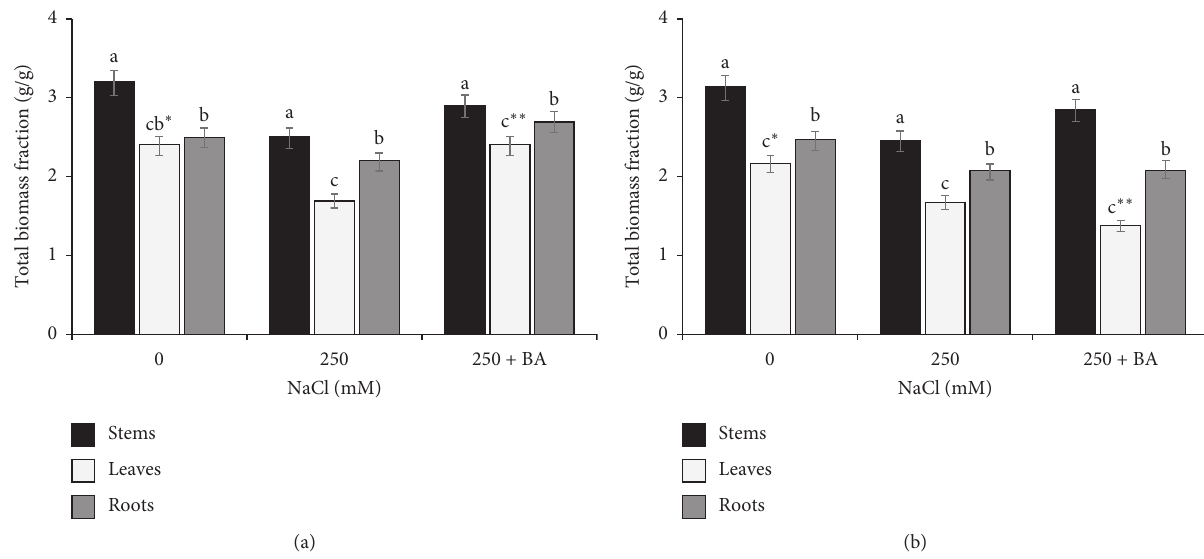
Figure 1: Total biomass fractions of NaCl stressed soybeans cultivar LS678 (a) and Peking (b). Each value represents the mean of three replicates ± SE. Table 3: Mean biochemical and physiological response of Peking and LS678 soybean plants subjected to salinity stress. Cultivar